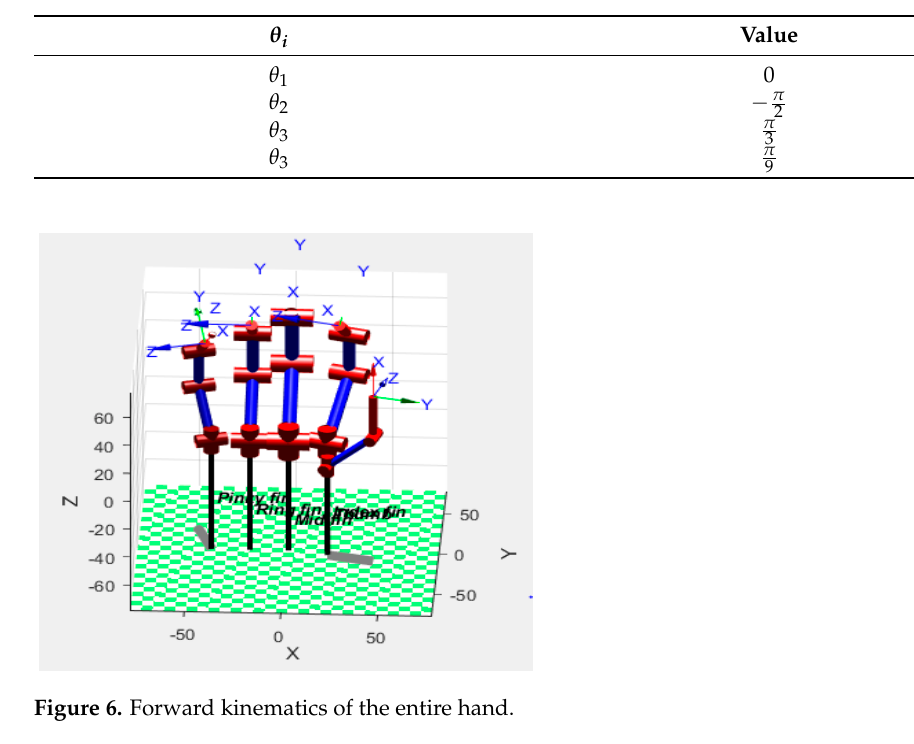
Table 2. Angles selected for the middle finger.